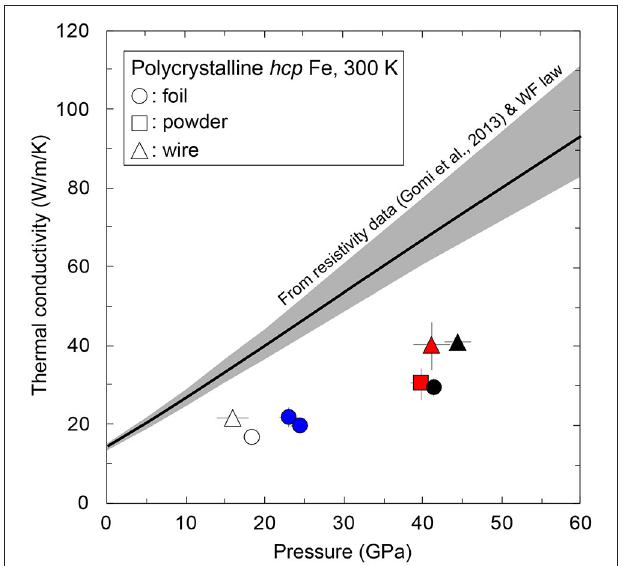
FIGURE 10 | Thermal conductivity of polycrystalline hcp iron as a function of P at 300K. The hcp iron samples were synthesized from foil (circles), powder (square), and wire (triangles) starting materials. Black line with gray band shows κ el of hcp iron calculated from the resistivity of hcp iron ( Gomi et al., 2013 ) and the Wiedemann-Franz (WF) law (Equation 1). The present conductivity data were obtained along DAC compression axis, while the resistivity of hcp iron (Gomi et al., 2013) was measured along the direction normal to DAC compression. Pairs of symbols with same color show similar pressure and were used to calculate the anisotropy in thermal conductivity.